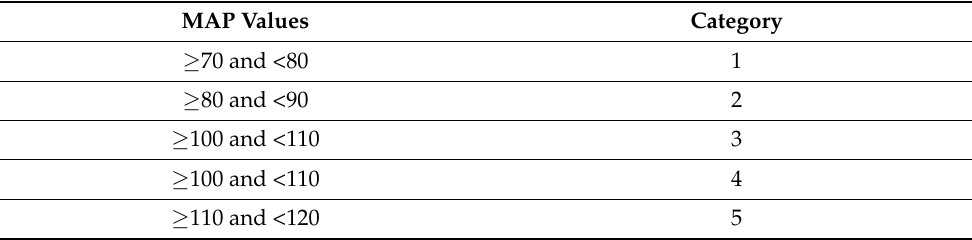
Table 3. MAP categorical